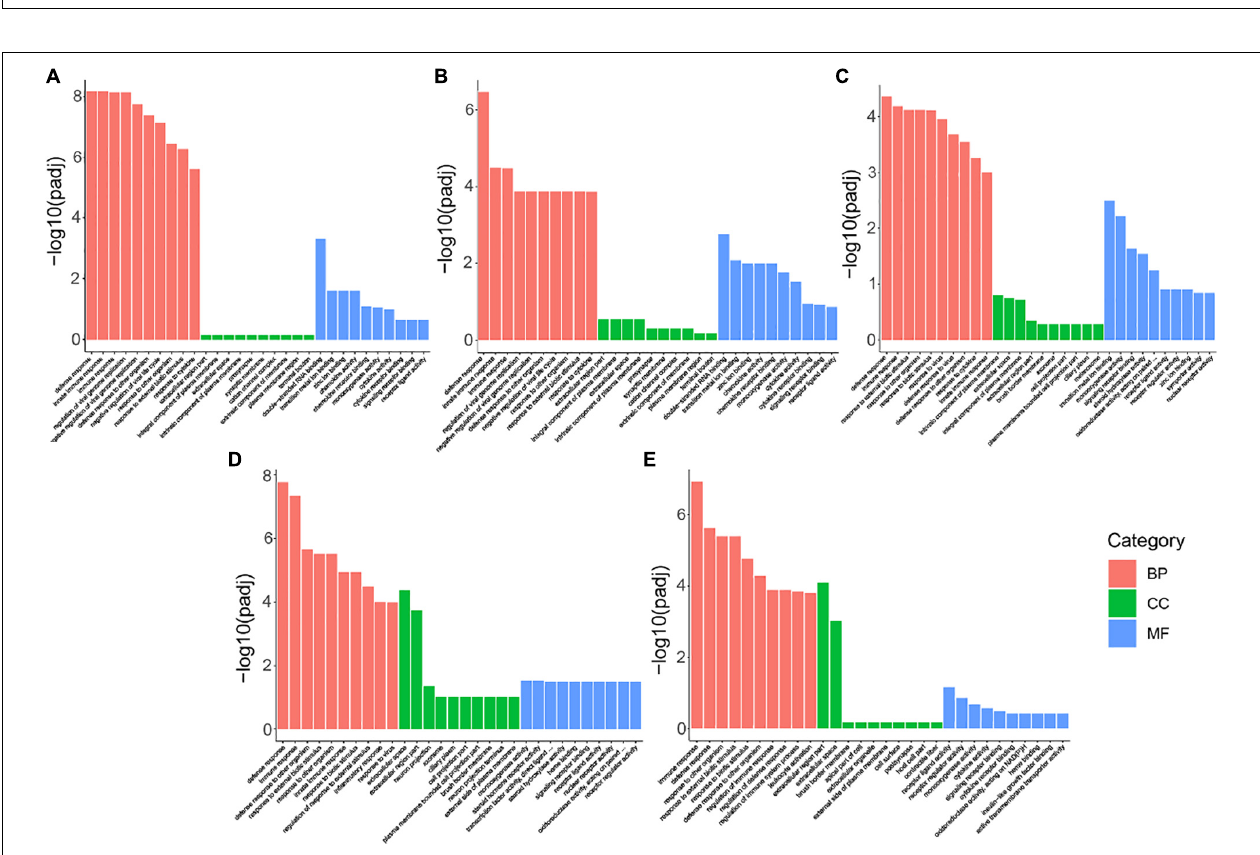
FIGURE 4 | GO function enrichment analysis of DEGs. Significantly enriched GO terms of each category, including biological process (BP), cellular component (CC), and molecular function (MF), were displayed in this figure. (A) Enriched GO terms in 6 h vs. Control. (B) Enriched GO terms in S12 vs. Control. (C) Enriched GO terms in S18 vs. Control. (D) Enriched GO terms in S24 vs. Control. (E) Enriched GO terms in S36 vs. Control.